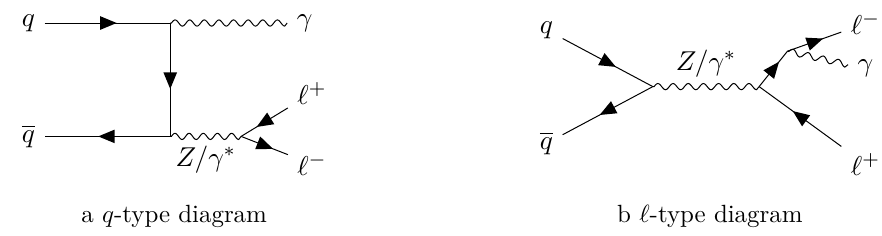
Figure 1. Sample LO diagrams for ‘ + ‘ − γ production with two different resonance stuctures.